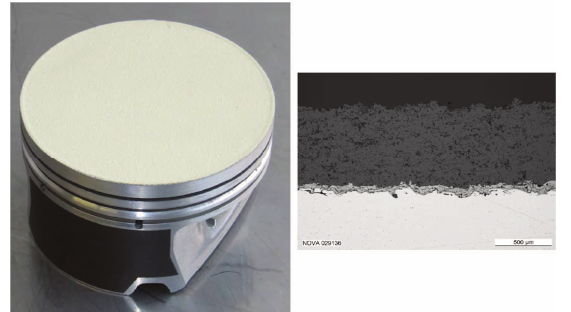
Fig. 7. Piston surface coated with zirconium oxide